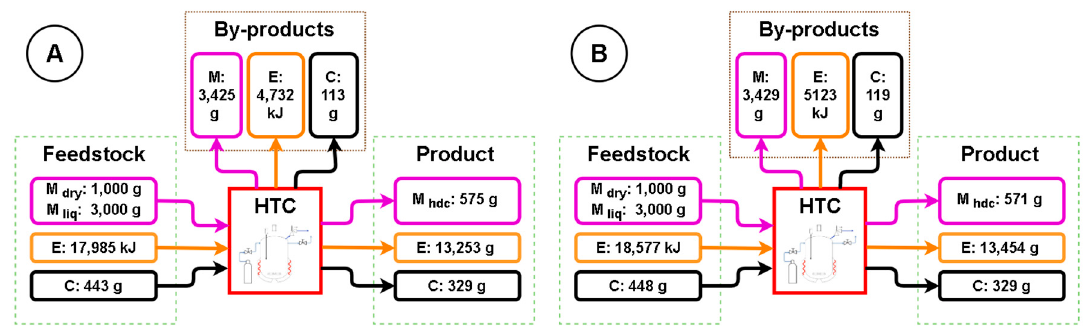
Figure 14. Mass, energy, and carbon balance for selected HTC parameters: A–Barley-based BSG after HTC at 200 °C, 60 min; B–Wheat-based BSG after HTC at 200 °C, 60 min. (M–mass; M dry –mass of dry solids; M liq –mass of water; M hdc –mass of dry hydrochar; E–energy; C–carbon).